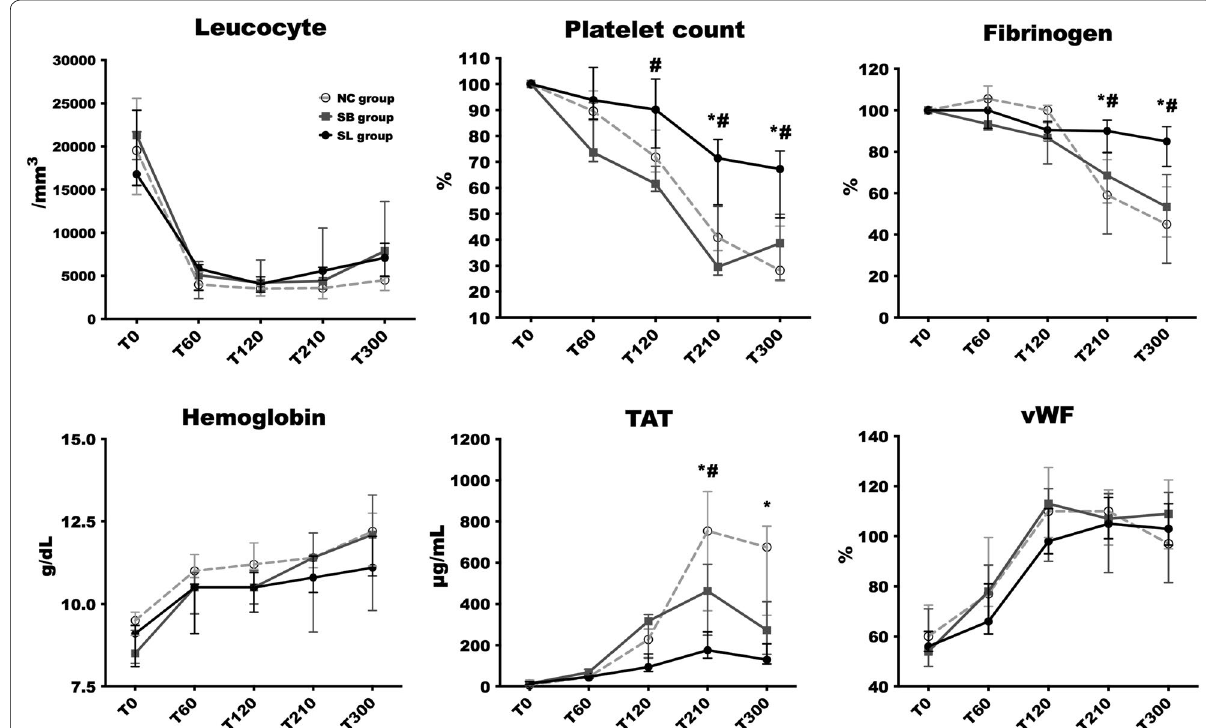
Fig. 3 Changes in leucocyte, platelet count, fibrinogen, haemoglobin, TAT and vWF in the three groups. Considering the differences between groups for platelet count and fibrinogen at baseline, values are expressed as a percentage of the first value. Open circles and dotted line: NC group ( n 5); squares and grey line: SB group ( n 5); closed circles and black line: SL group ( n 5). Results are expressed as median with interquartile = = = ranges. * p < 0.05, NC versus SL. # p < 0.05, SB versus SL. & p < 0.05, NC versus